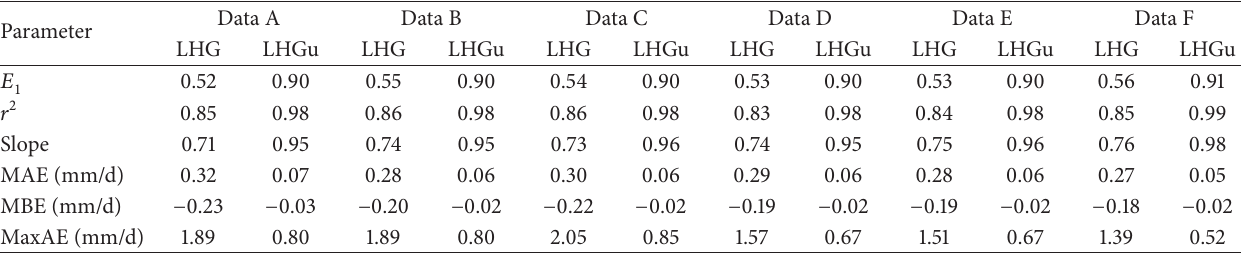
𝑢 opt 2 the performance will be better and vice versa, but the performance cannot exceed 𝐸 opt 1 neither can it fall